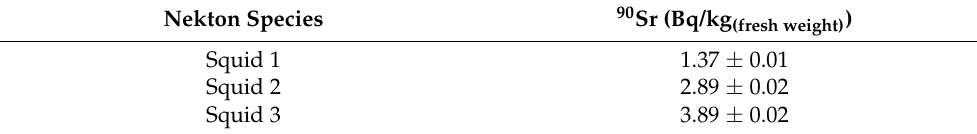
Table 2. Specific activity of 90 Sr in the squid samples (uncertainties are expressed at k =